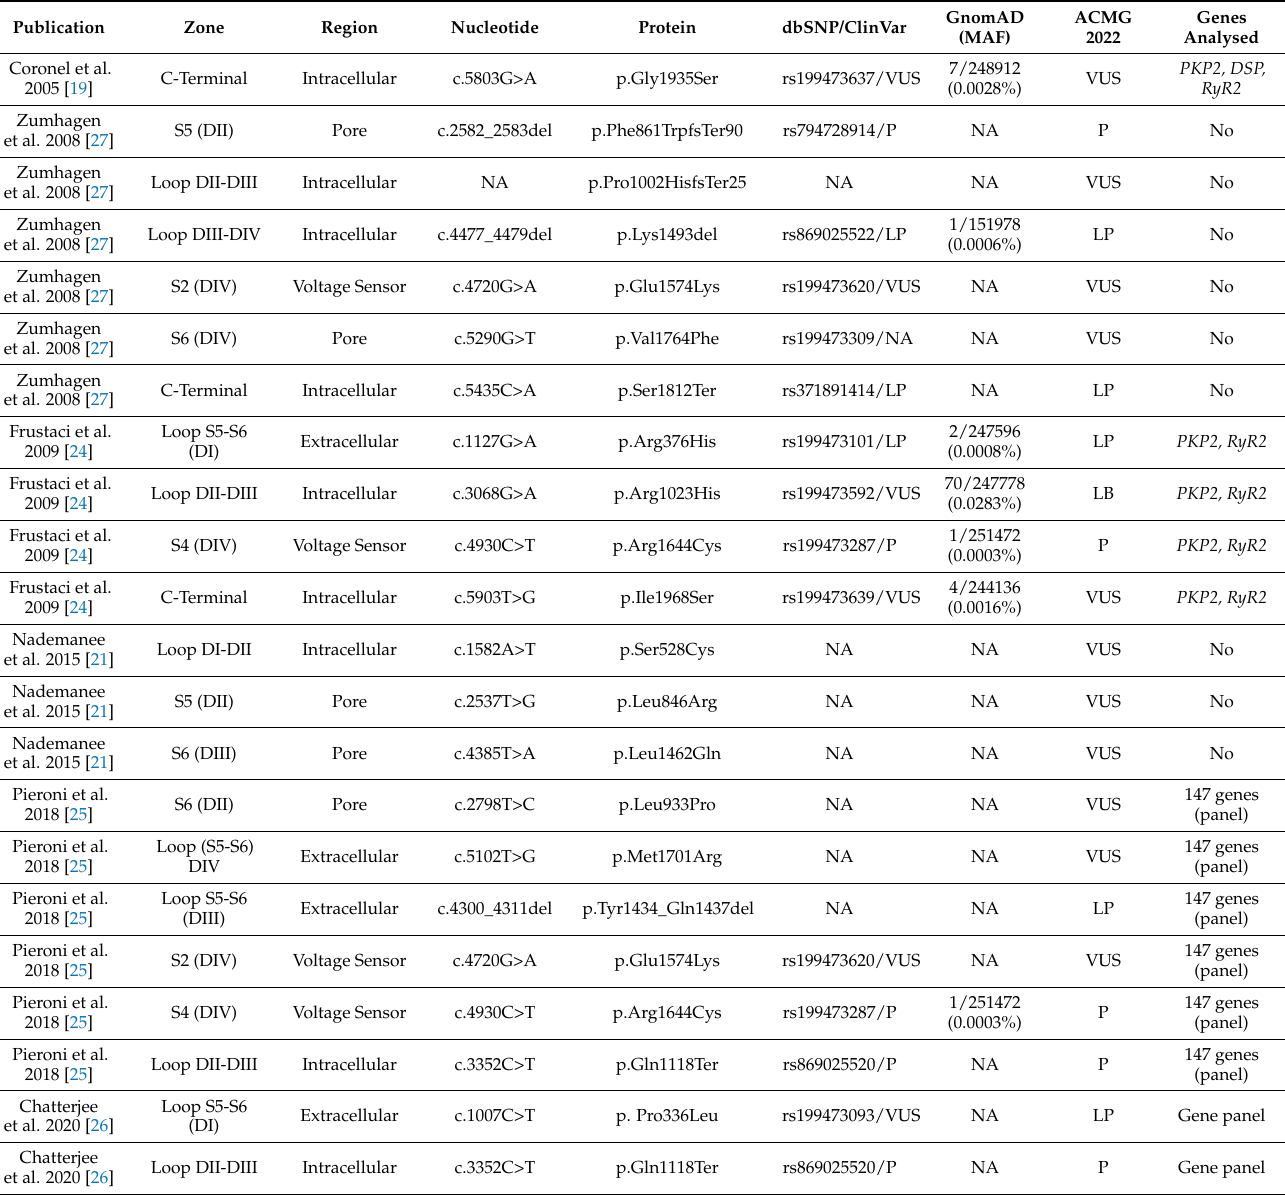
Table 3. Genetic data of variants in the SCN5A